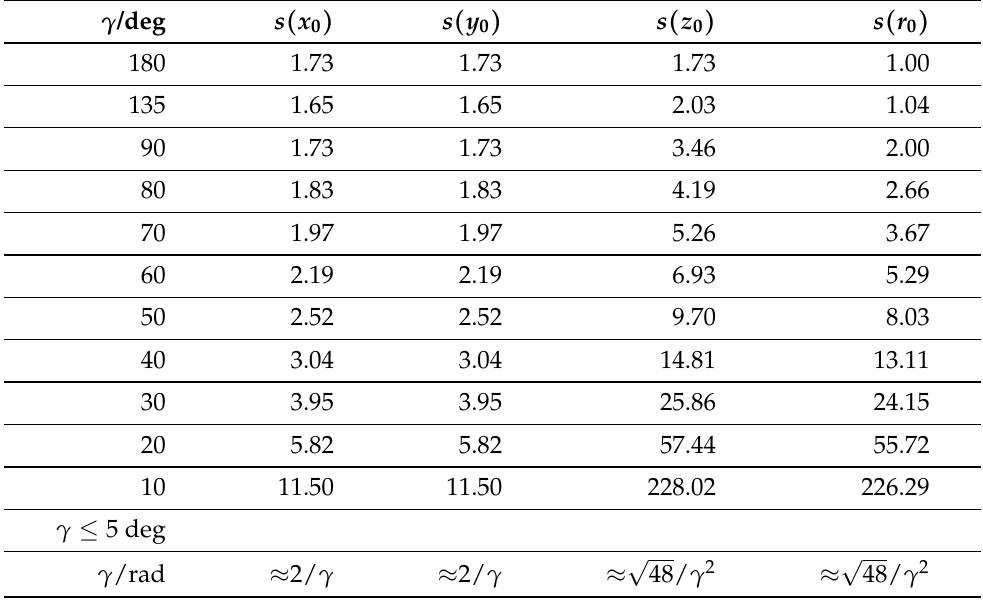
Table 2. Cap of a sphere. Square roots s ( a ) of the diagonal elements of V γ in (18). For points x 1: m approximately uniformly distributed on the sphere with elevation angle satisfying π /2 − γ ≤ φ i ≤ π /2 √ I , the uncertainties u ( a ) = σ R s ( a ) / m . and for point-cloud variance matrix σ 2 R γ